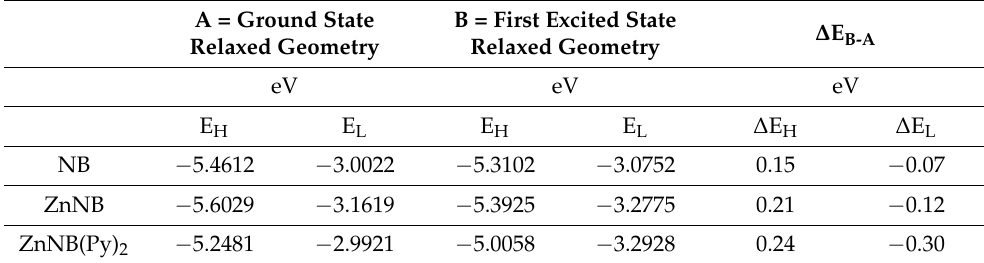
Table 1. Homo and Lumo energy levels of the ground state relaxed geometry (A) and the first excited state relaxed geometry (B), and their difference ∆ E B-A